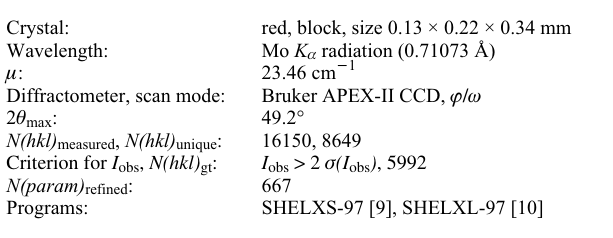
Table 1. Data collection and